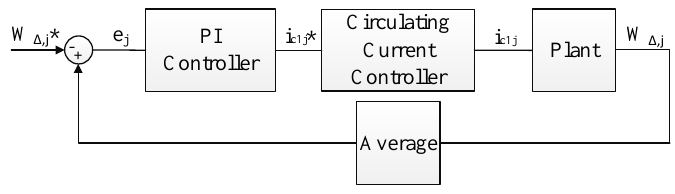
Figure 5. Arm energy balancing closed loop control system.